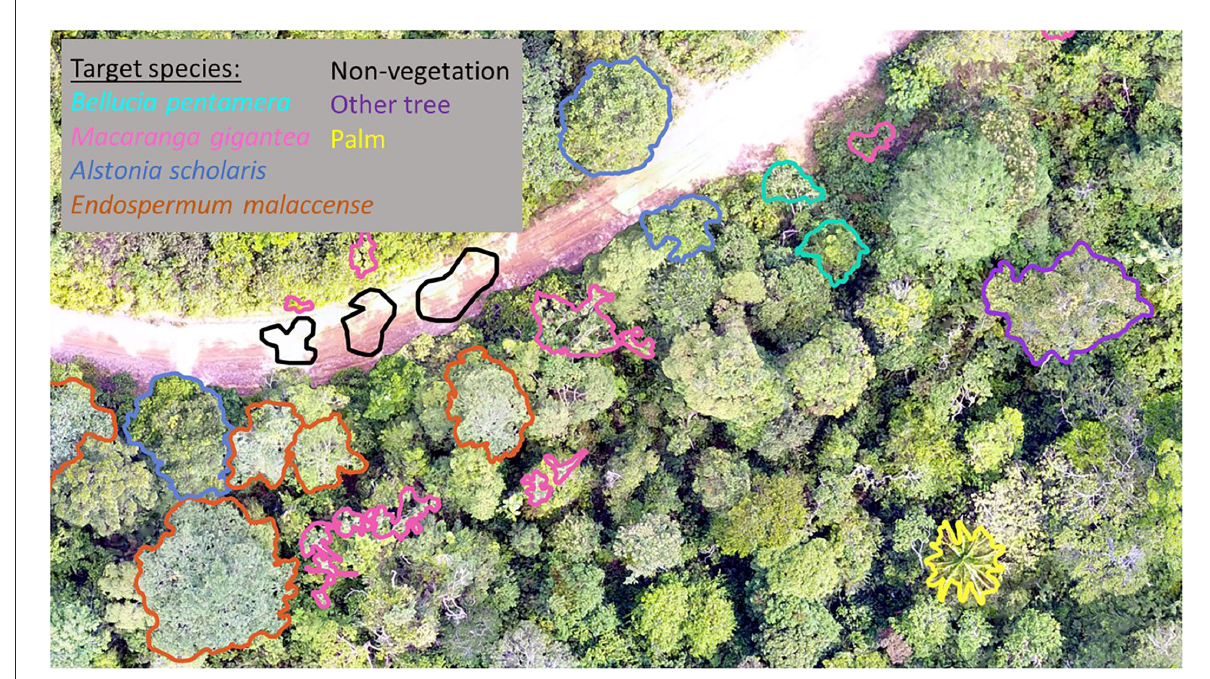
FIGURE4 Example manual digitisation of oil palm, other species and miscellaneous regions completed with UAV